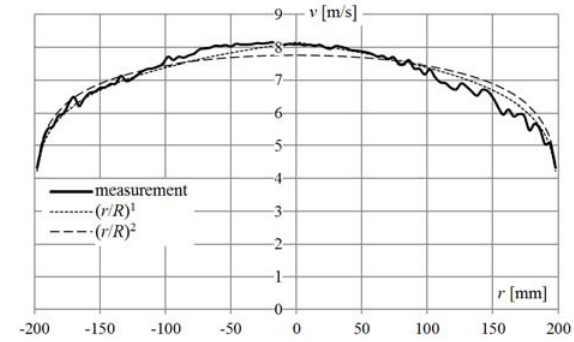
Fig. 4 . Velocity distribution in circular